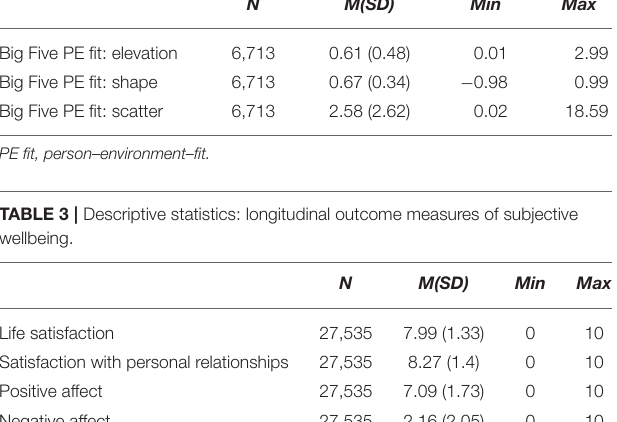
TABLE 2 | Descriptive statistics: predictors of subjective wellbeing.